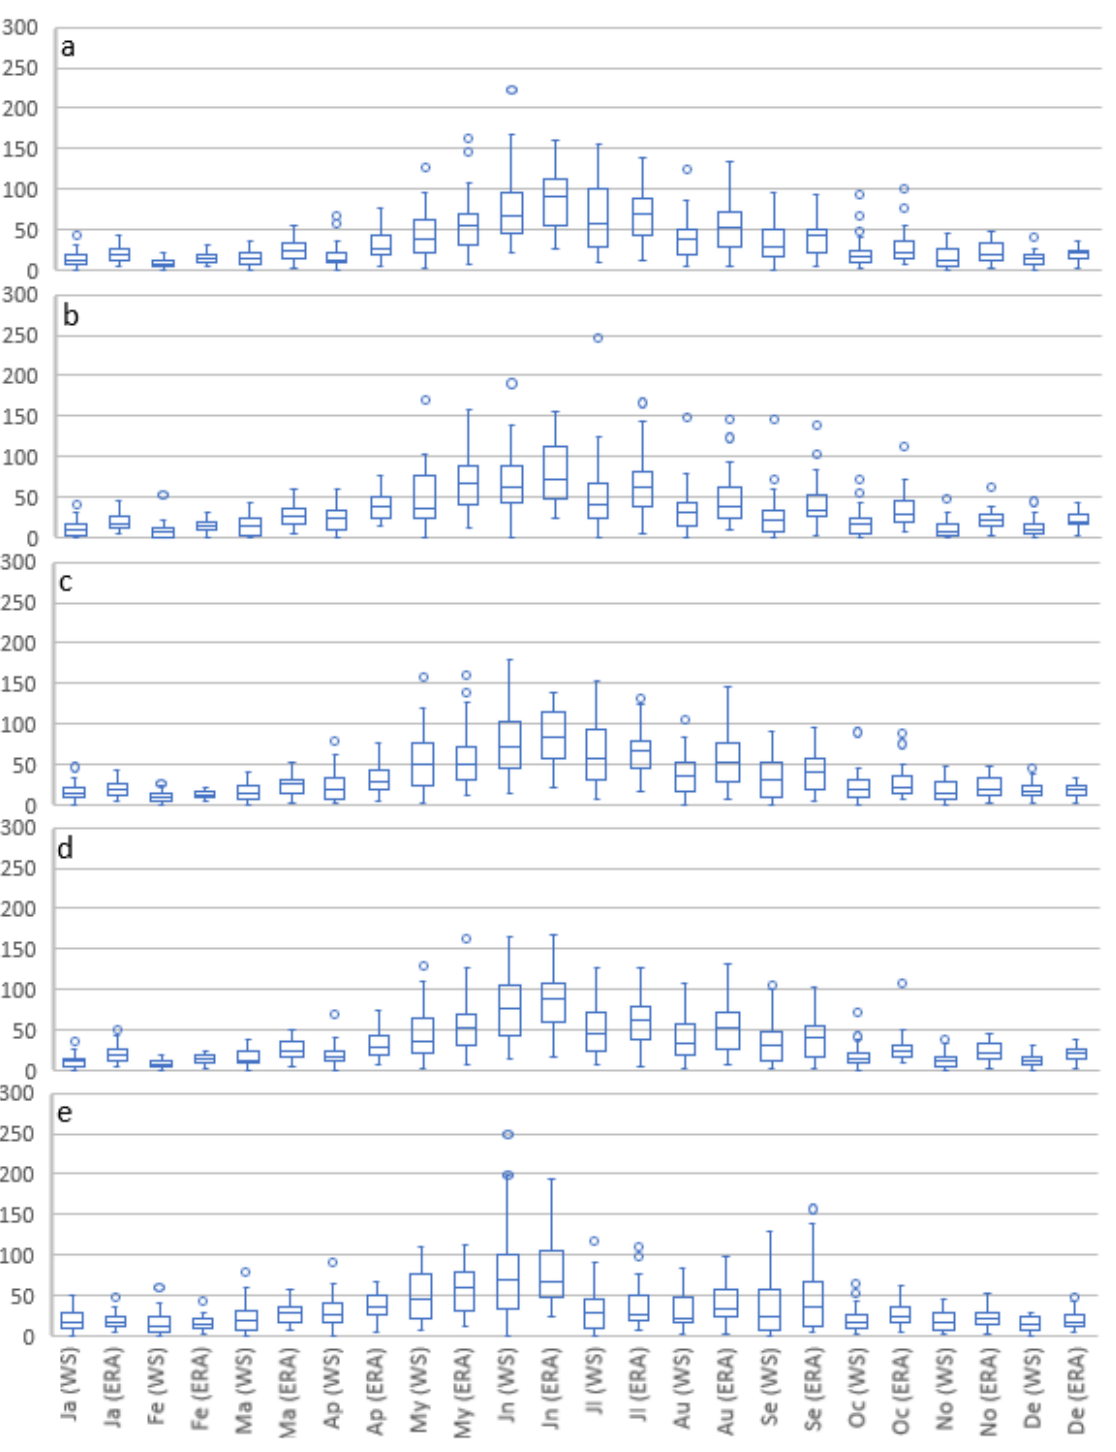
Figure 2. Boxplot of monthly precipitation (mm)—First the weather wtation (WS) data, followed by the ERA5-ECMWF (ERA) data (mm) in the Mixed Ecoregion for Beechy ( a ), Coronach ( b ), Rock Point ( c ), Swift Current ( d ), and Taber ( e ) in the period 1981–2019. The horizontal lines inside the boxes represent the median and the vertical lines at the top and bottom of the box represent the third and first quartiles, respectively. The ends of the vertical lines indicate the maximum (upper) and minimum (lower) values, and the isolated points show outliers.